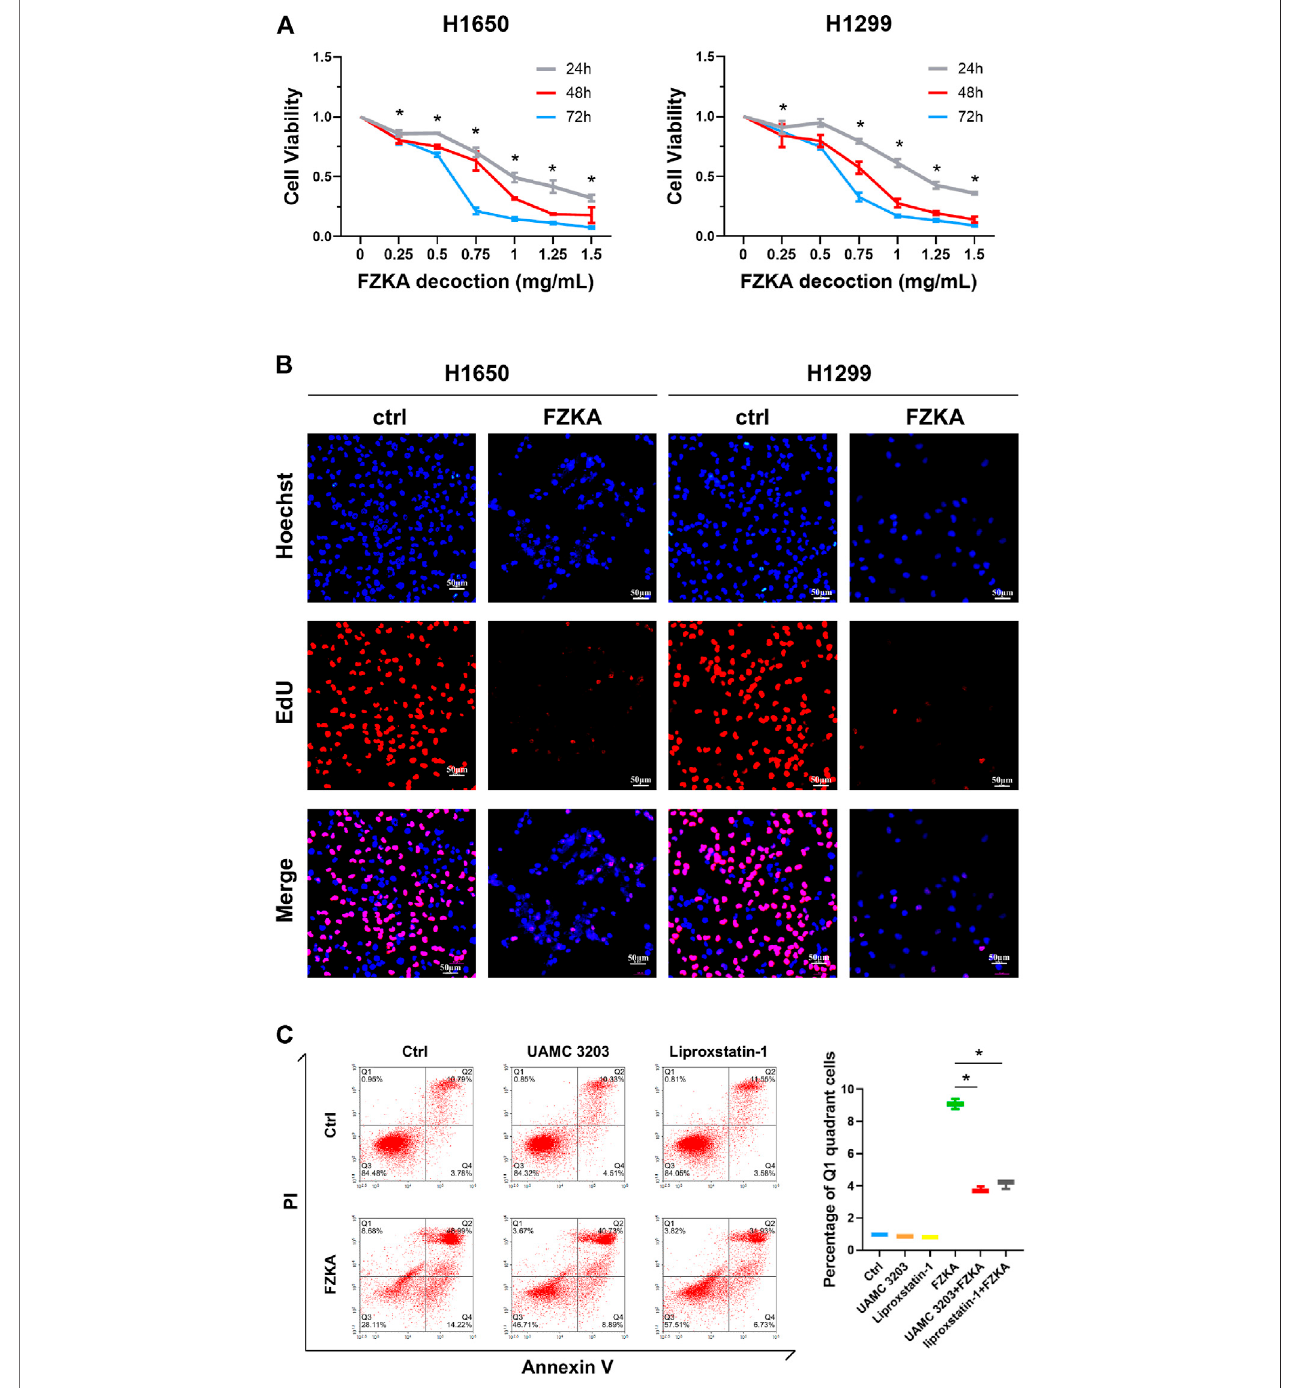
FIGURE 1 | FZKA inhibited the growth of NSCLC cells in vitro . (A) , H1650 and H1299 cells were treated with different concentrations of FZKA for up to 72 h. The cells were collected and processed for CCK-8 assay as described in the Materials and Methods section, * p < 0.05. (B) , H1650 and H1299 cells were treated with FZKA (1 mg/ml) for 24 h, followed by EdU proliferation assay. (C) . Cultured A549 cells were treated with FZKA (1.5 mg/ml), in the presence and absence of ferroptosis inhibitors. Cell were stained with Annexin V and PI and analyzed by fl ow cytometry, * p < 0.05.